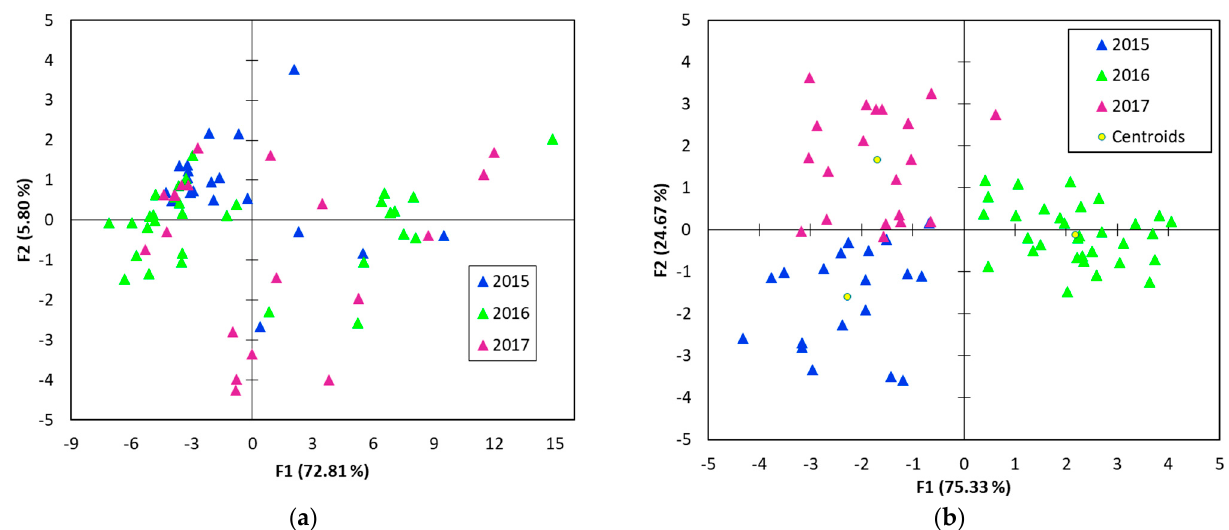
Figure 5. ( a ) PCA and ( b ) DA F1/F2 score plot showing the separation between the 3 harvest